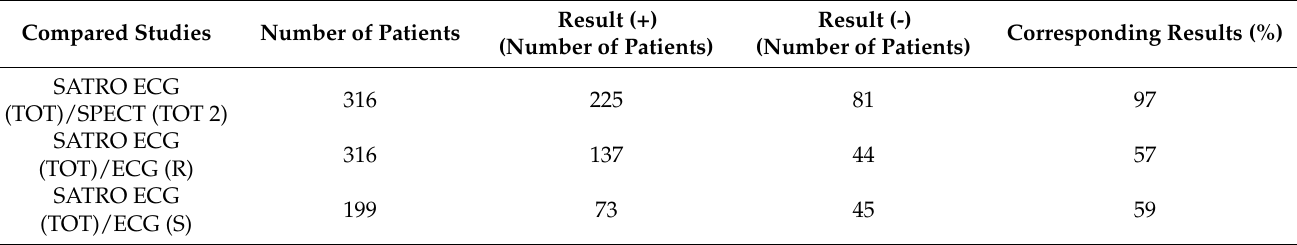
Table 2. The frequency of consistent results of the compared methods.